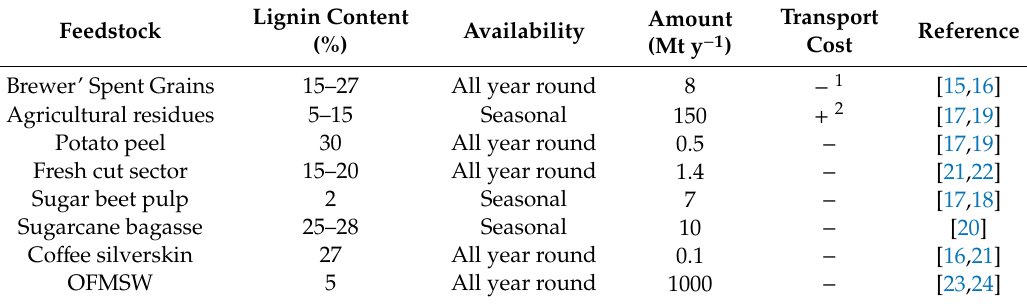
Table 2. Features of the main feedstock currently